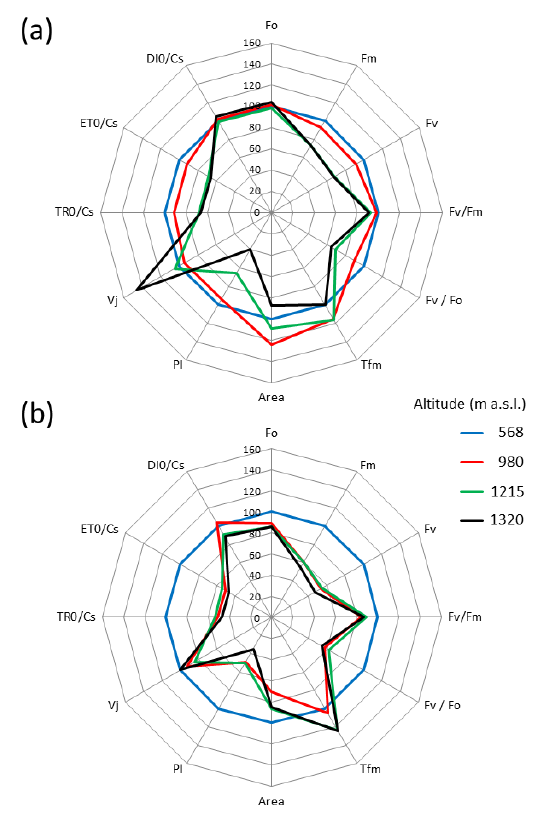
Figure 3. Values of selected Chl a fluorescence parameters of green alder ( Alnus viridis ) leaves (in % of control), recorded in ( a ) July and ( b ) September all field sites—in localities at elevations 980, 1215, and 1320 m a.s.l. The control was based on values from the lowest locality (586 m a.s.l.).